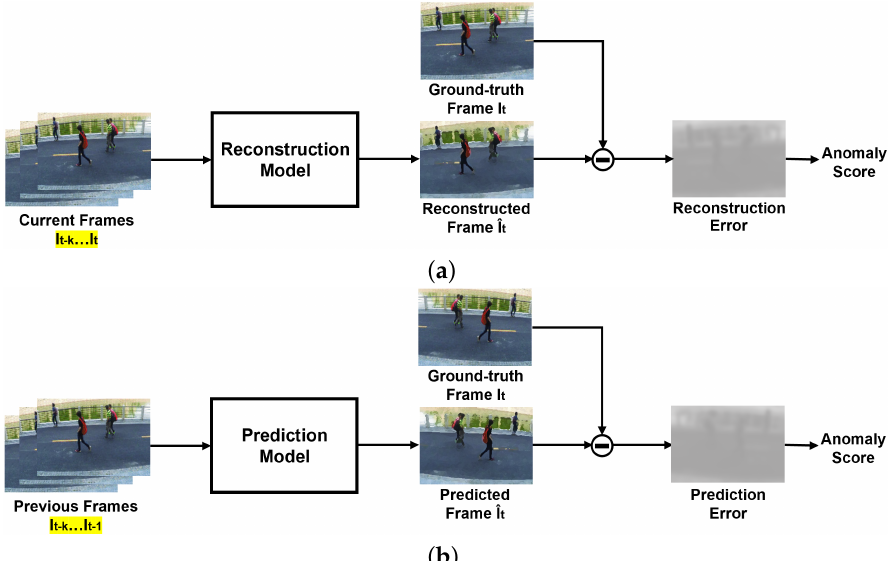
Figure 1. Pipelines of semi-supervised methods for video anomaly detection. They differ on the use of the current frame for generation, as highlighted in yellow. ( a ) Generic pipeline of reconstruction methods. ( b ) Generic pipeline of prediction